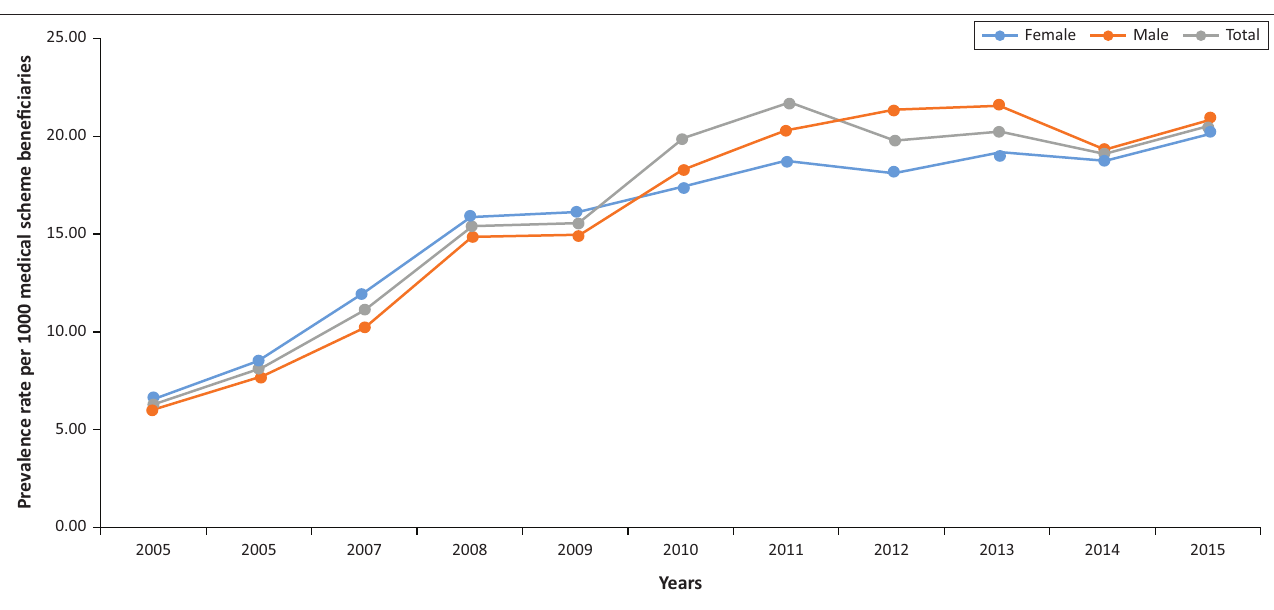
FIGURE 1: Prevalence rate of human immunodeficiency virus or acquired immunodeficiency syndrome patients per 1000 medical scheme beneficiaries per gender from 2005 to 2015.